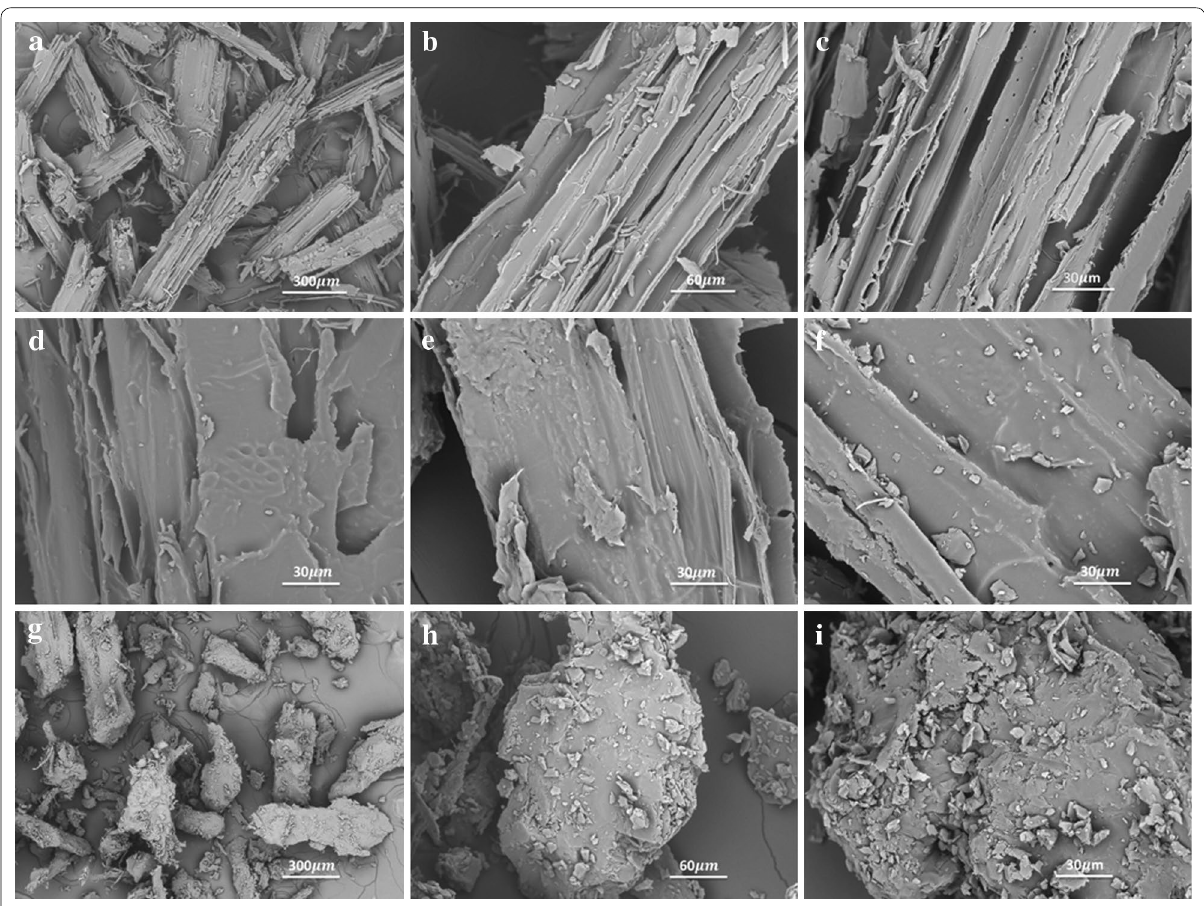
Fig. 4 SEM photographs of the a waste sawdust ( CPCMs‑3 ( 800), g CPCMs‑4 ( ×